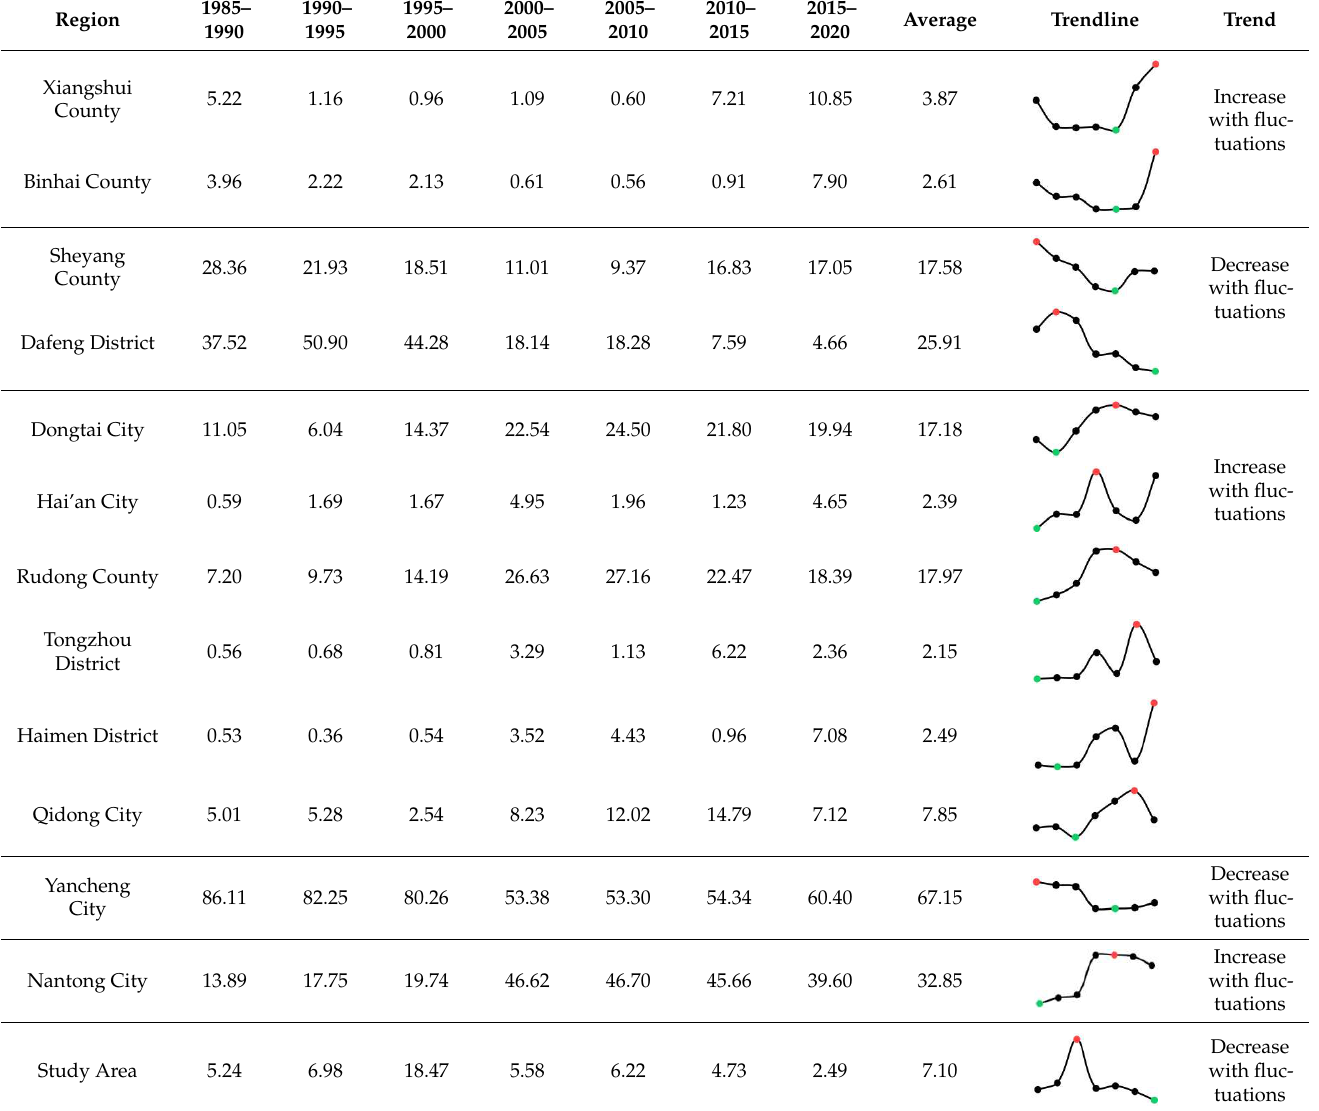
Table 6. Proportion of deteriorated coastal wetland degradation grade in each county and city compared to the total deteriorated area in the study area.